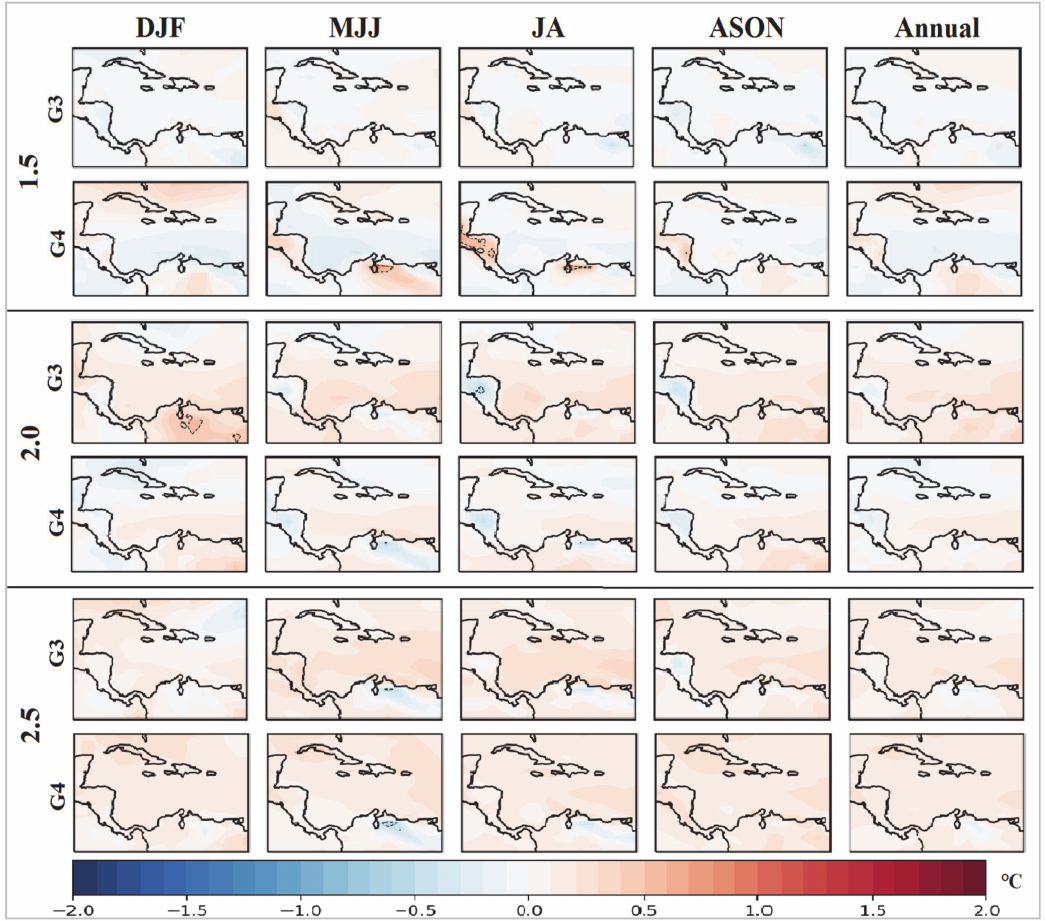
Figure 11. Composite maps of air temperature for G3 and G4 minus HadGEM_unaltered. Composites are for the 11-year periods centered on when the respective experiments attain the 1.5, 2.0 and 2.5 ◦ C global warming targets. Units in ◦